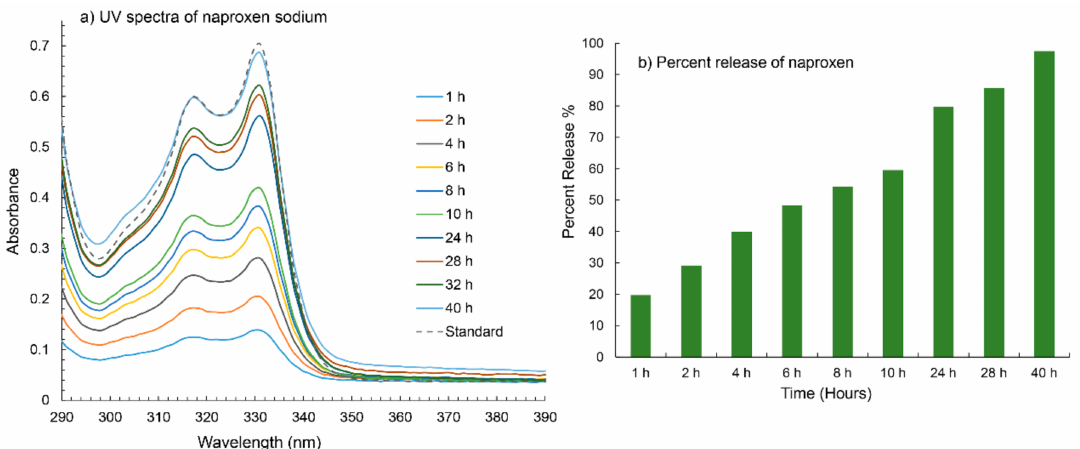
Figure 12. The UV-Vis spectra ( a ) and percent release profile ( b ) of naproxen sodium over time from a co-gel formed by compound 13 (1.0 mg/mL gel) in DMSO:H 2 O (5:95). The gel was prepared using 2 mg of compound 13 and 0.5 mg of naproxen sodium in 2.0 mL of DMSO:H 2 O (5:95) solution. Percent release was calculated using absorption values at 331 nm for each time